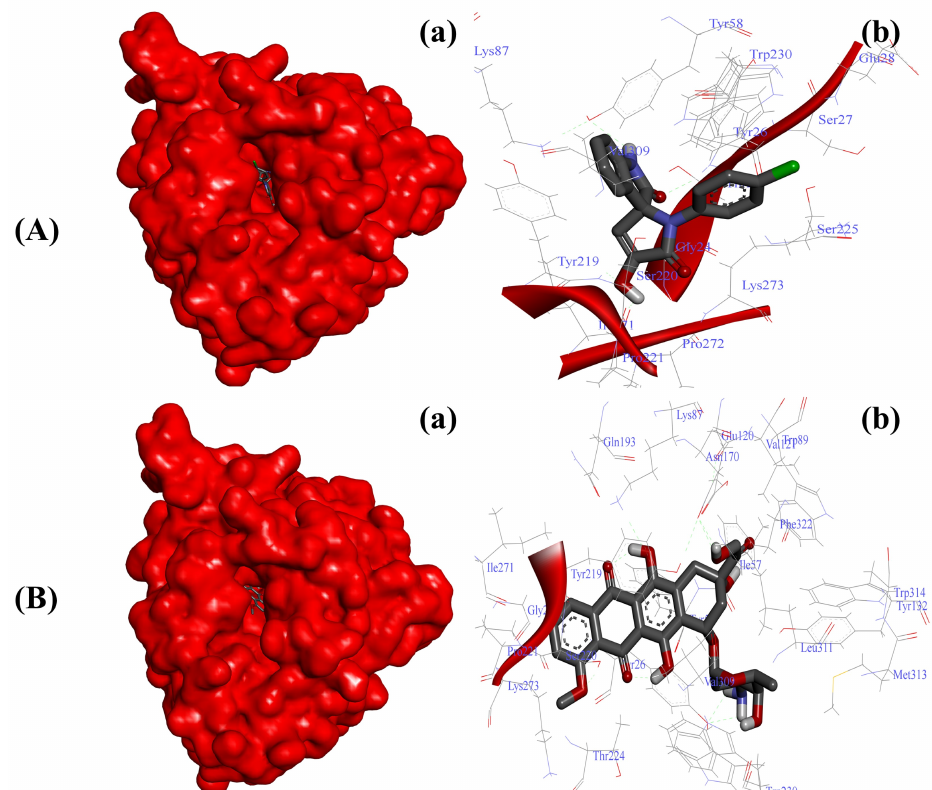
Figure 4. Substituted SOX ( 4a ) inhibits the activity of 5- β -reductase/AKR1D1 (PDB ID: 3CAQ). ( A ) Binding pattern of the substituted SOX ( 4a ) against human AKR1D1 ( ∆ G: − 8.73 Kcal/mol); ( B ) Binding pattern of doxorubicin against human CD44 ( ∆ G: − 10.01 Kcal/mol). Subpanels ( a ) repre- sent the interaction of 4a and doxorubicin inside the active pocket of the target protein (represented as a red surface). Subpanels ( b ) show the 2D image of the interacting residues of the AKR1D1 with our